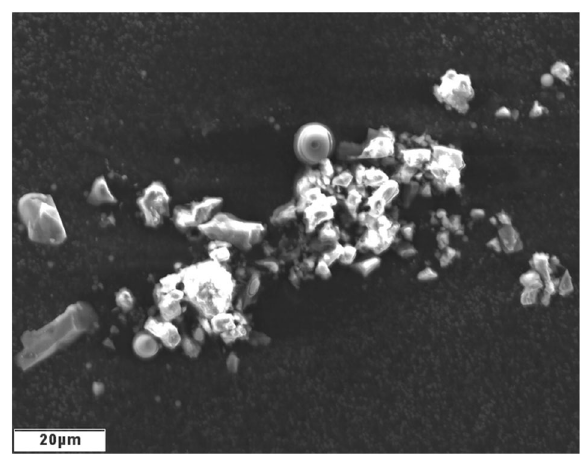
Fig. 2 Lunar dust grains. Scanning electron microscopy images of native lunar dust grains collecting during an Apollo 17 EVA 82 . Copyright © NASA Public Domain